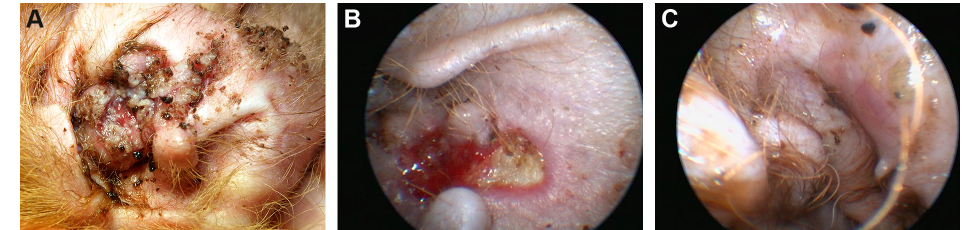
Figure 1. Clinical phenotype. ( A ) Concave pinnae of the right ear showing well demarcated crusting, eroded and ulcerated skin plaques. ( B ) Medial aspect of the right ear canal with well demarcated ulcerated lesions visualized via video otoscopy after crusts had been flushed away. ( C ) Same aspect of the ear canal: Intact, slightly erythematous skin after repeated laser